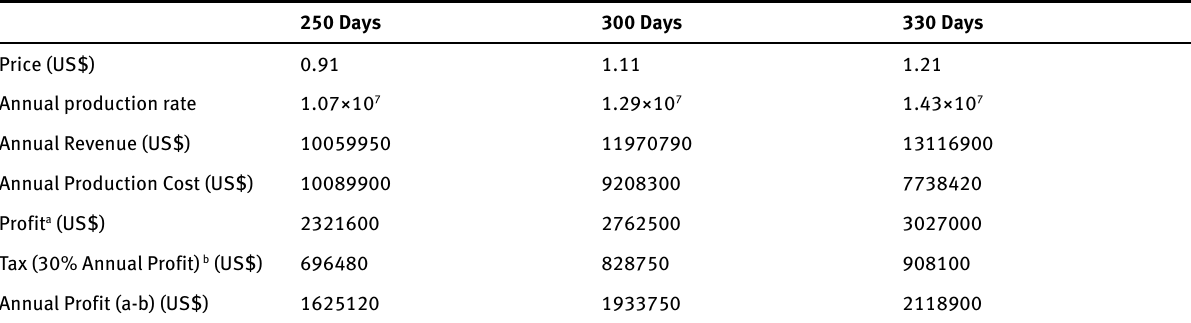
Table 4 : Annual profitability of the cookies production plant